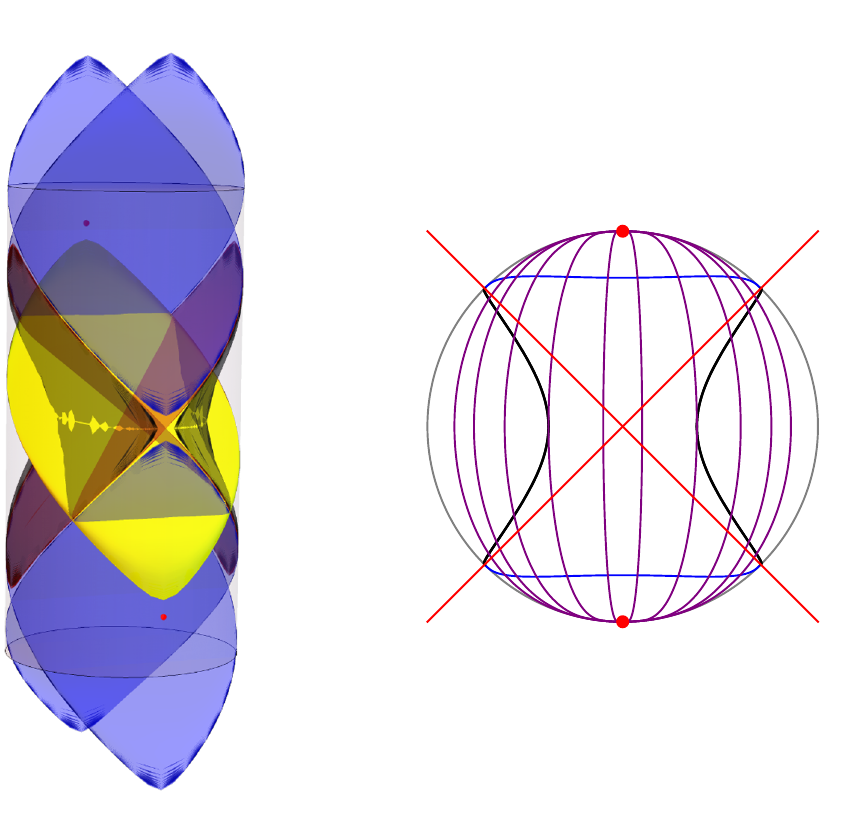
Figure 7 . Left: features of the rotating BTZ geometry represented in global AdS coordinates of (3.3). A point in I.B and its \image" on I.C are shown with red dots. The bulk lightcone connecting them is the yellow surface. The excision surface is shown in black, the outer horizons in blue, the inner horizons in red. One may recognize the Penrose diagram, but as we proceed upwards, we need to twist it. Right: various features as they intersect the light sheet from the left (cid:12)gure. The purple lines are the actual null geodesics that make up the light sheet and one sees that many of them do not fall behind the excision